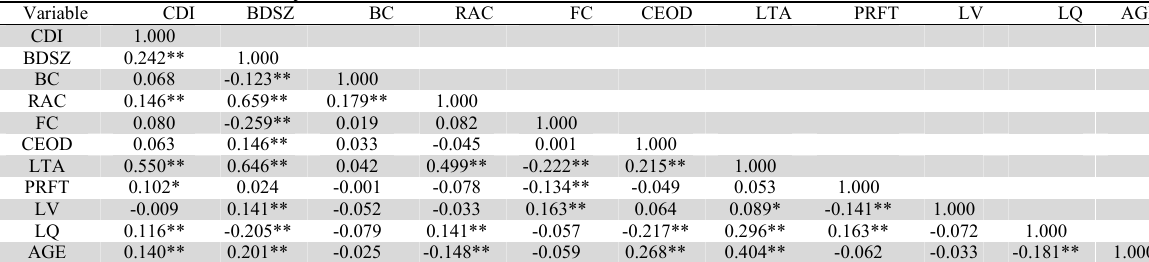
Pearson Correlation Analysis